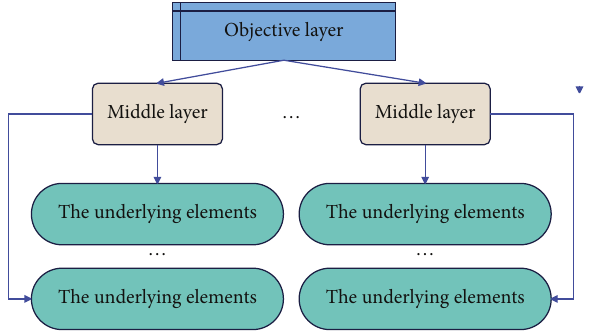
Figure 2: The general structure of